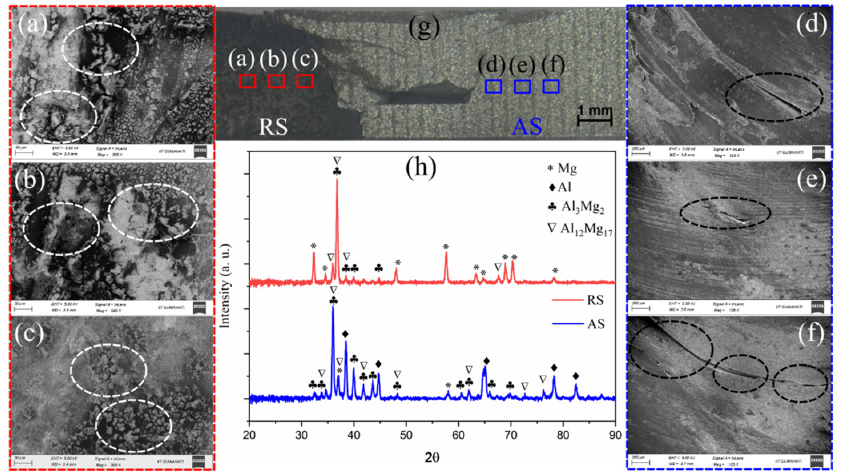
Figure 5. ( a – c )—microcracks in SZ on RS; ( d – f )—microcracks in SZ on AS; ( g ) a cross-section of AA6061-AZ31B SZ; ( h ) XRD patterns of RS and AS at 900 rpm and 30 mm/min. AA6061-AZ31B SZ; ( h ) XRD patterns of RS and AS at 900 rpm and 30